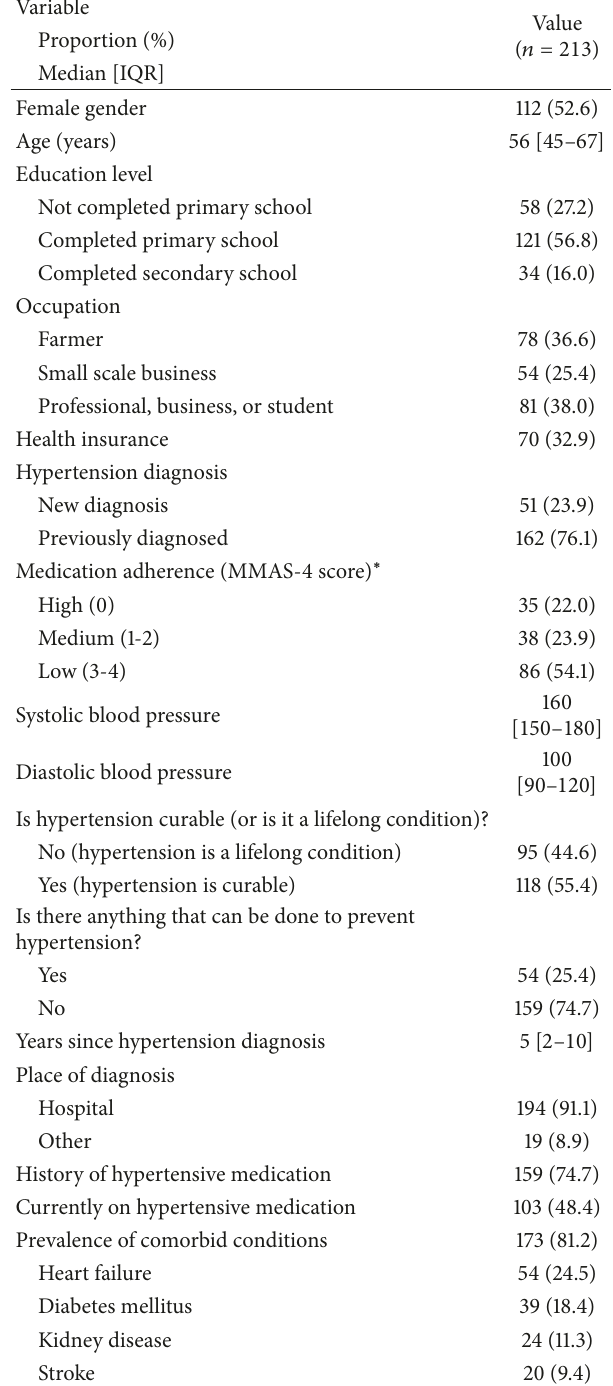
Table 1: Sociodemographic and clinical characteristics of 213 consecutive adults hospitalized at Bugando Medical Centre with hypertension-related